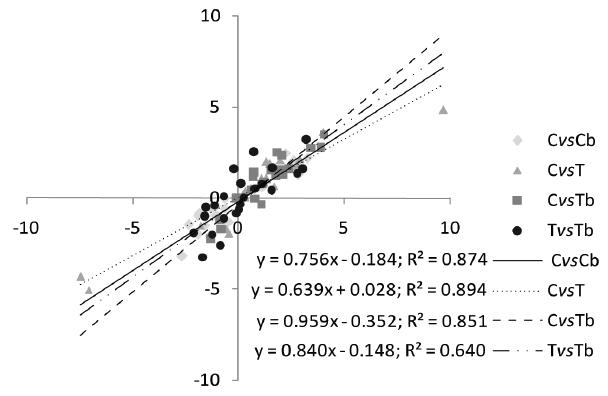
Figure 1. Validation of the RNA-seq approach using q-RT-PCR. Twenty-two genes were arbitrary selected, from highly up-regulated to highly down-regulated contigs. Their levels of expression were quantified by q-RT-PCR, and the results were compared with those obtained using the RNA-seq approach. The log2 changes in expression based on q-RT-PCR and RNA-seq analyses were closely correlated for all treatments, indicating the accuracy of the RNA-seq approach for quantification.